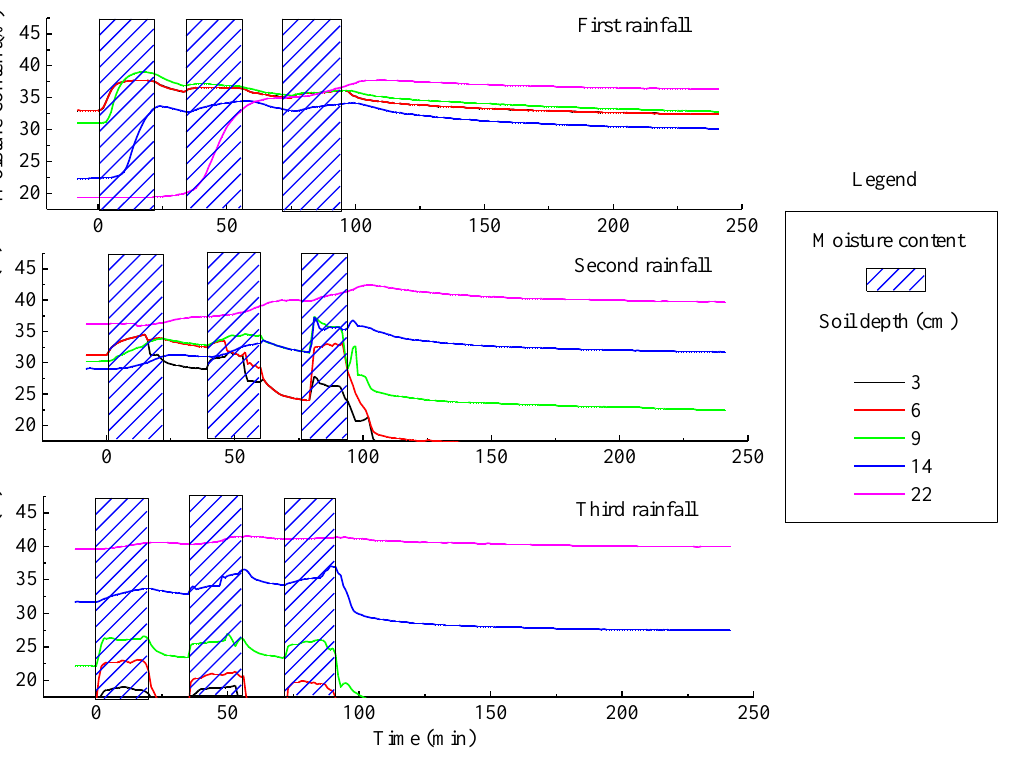
Figure 11. Dynamic change process of soil water content of the sand-covered slope in 2.5 mm/min rain.